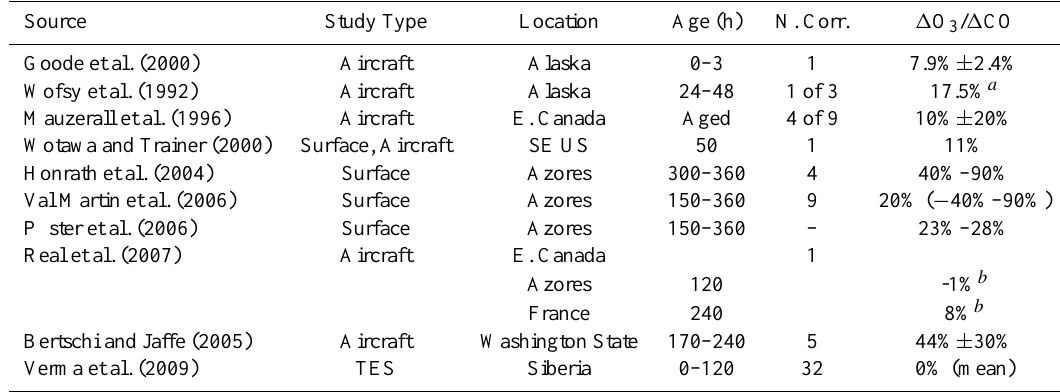
Table 2. Previous measurements of O 3 enhancement ratios (mol/mol) for boreal plumes.